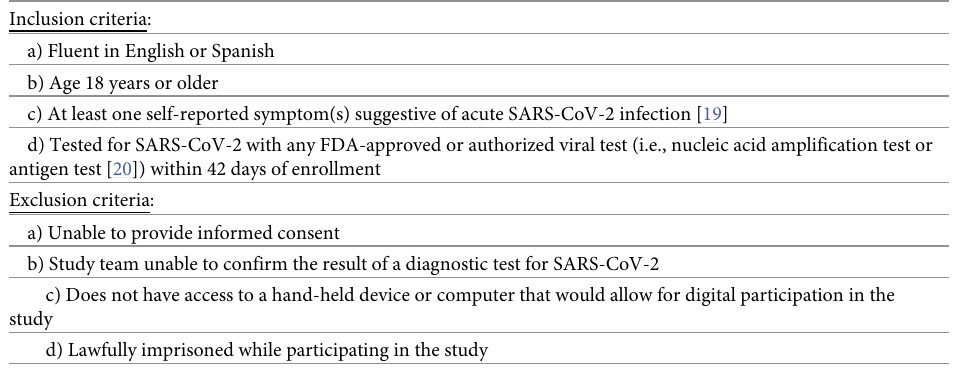
Table 1. Inclusion and exclusion criteria. Inclusion criteria: